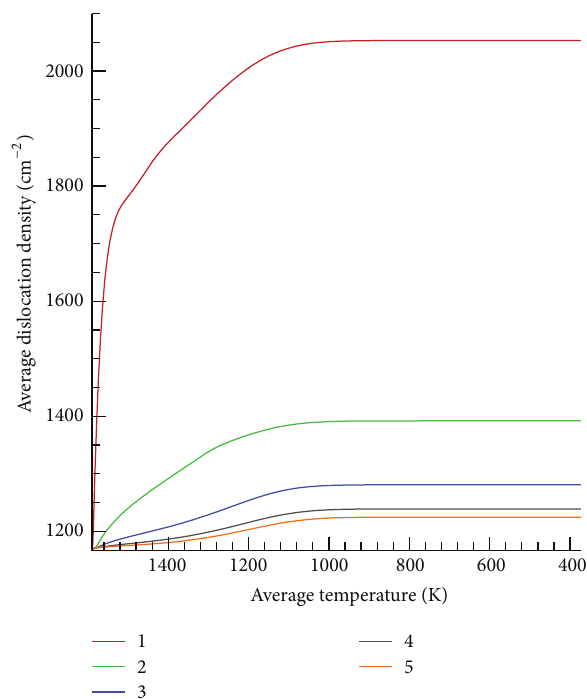
Figure 5: Average dislocation density versus average temperature during the cooling process.